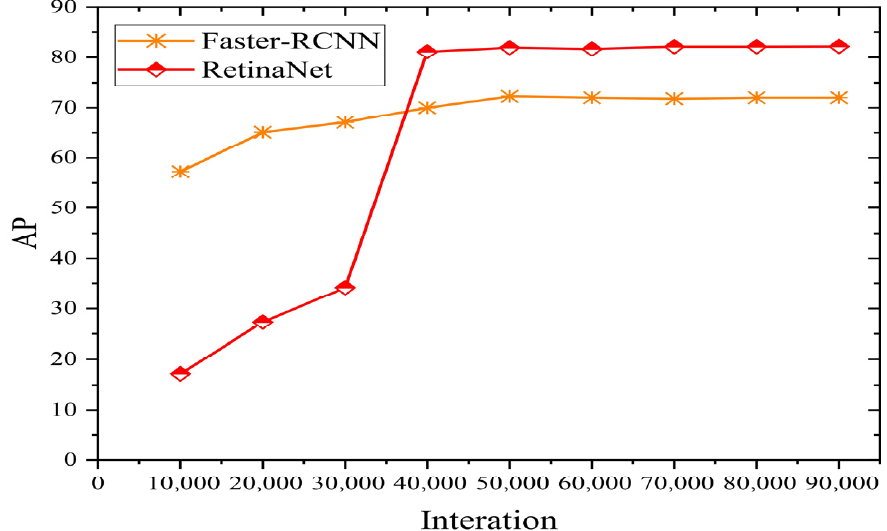
Figure 7. The AP value of Faster R-CNN and RetinaNet for identifying wheat ears. A total of 90,000 iterations were executed to train the model, where 10,000 iterations were executed to calculate the AP value of the Faster R-CNN and RetinaNet (IOU set to 0.5). Each model uses the VOC data set for pre-training and initialization. The AP value and loss of Faster R-CNN and RetinaNet for identifying wheat ears are shown in Figure 7. As the number of iterations increases, the accuracy of the model gradually increases. When the number of iterations reaches 40,000, the accuracy of the model reaches its maximum. The Faster R-CNN model achieves high accuracy from the beginning, and the AP value does not increase significantly as the number of iterations increases. The AP value of the RetinaNet increases significantly between 30,000 to 40,000 iterations and then becomes stable to the maximum. This result is related to the two-part detection of Faster R-CNN. In Faster R-CNN, the first step generates region proposals that may contain a target to be localized, and the second step performs a fine distinction between the specific targets contained in each candidate region. Therefore, high accuracy is achieved at the beginning of the iterative process. By contrast, RetinaNet performs one-stage detection, and it directly generates the position and category information of the target that derived from the object. This method is prone to category classification errors and inaccurate target location information at the beginning. Through continuous iterative training, the focal loss mechanism of RetinaNet continuously and rapidly reduces the loss value, and a stable detection result can be obtained after 35,000 iterations. Additionally, it can be seen from Figure 7 that the AP value of the RetinaNet is higher than that of the Faster R-CNN, indicating that the RetinaNet achieves the best AP; this is because RetinaNet extracts multi-scale semantic features, which greatly improve the AP value. The RetinaNet model has a strong advantage in wheat ear classification and box regression using derivatives. Though the Global WHEAT data set contains many types of wheat ear data, there are many wheat varieties globally, and even the same wheat varieties show great differences due to different growth environments. To better evaluate the performance of the